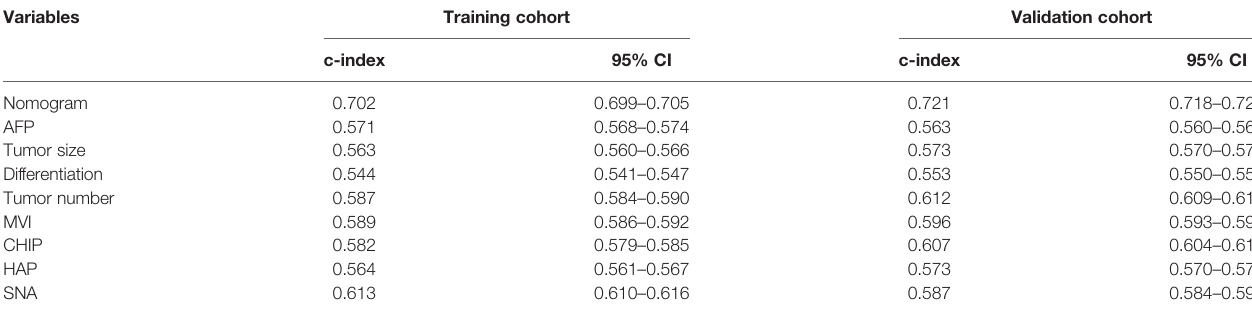
TABLE 4 | Ranking of clinical staging system using C-index for RFS in training and validation cohort.